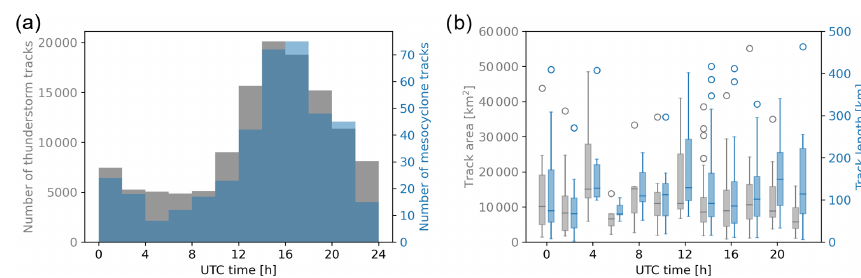
Figure 6. Diurnal cycle of convection (a) . Each 2h bin shows the number of tracks beginning at this time. Diurnal cycle of mesocyclone track properties (b) . Each 2h bin shows the cumulative track area and length of tracks beginning at this time.